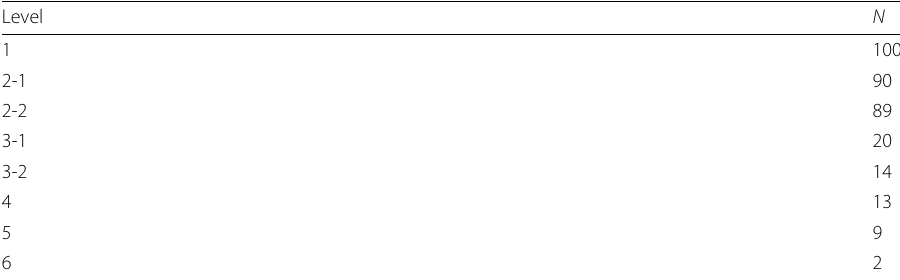
Table 2 Number of participants who cleared each level of the application Level